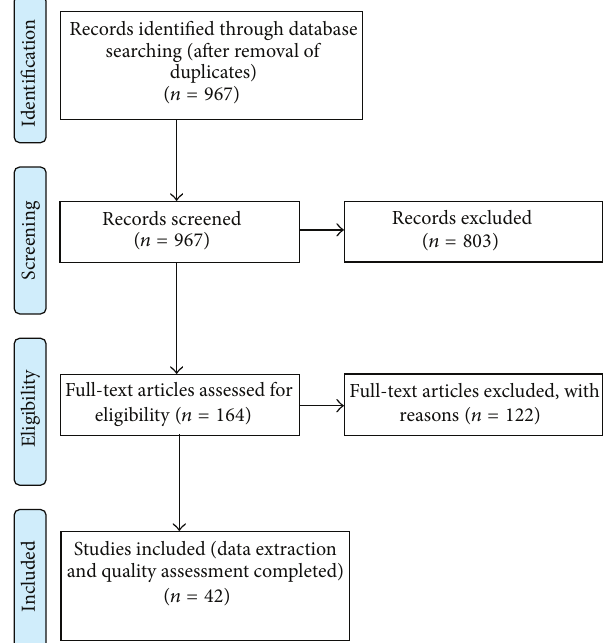
Figure 1: PRISMA flow